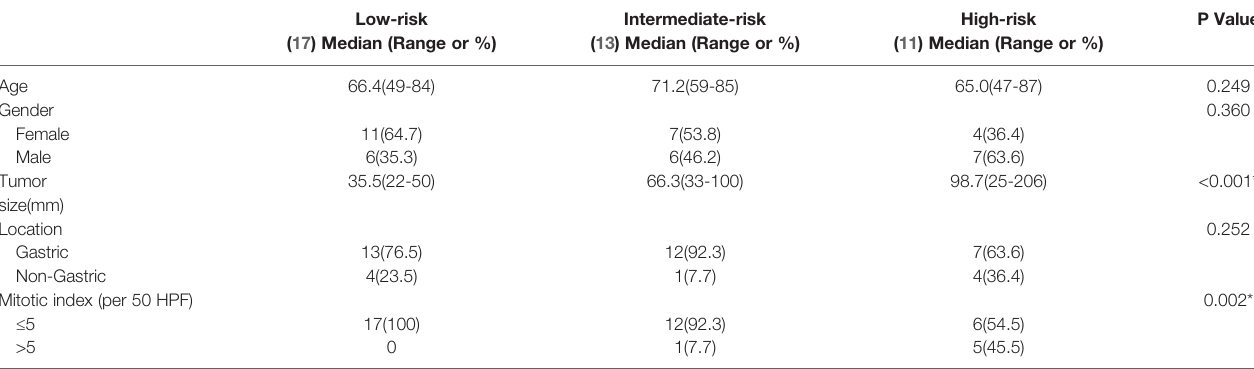
TABLE 2 | Baseline characteristics of